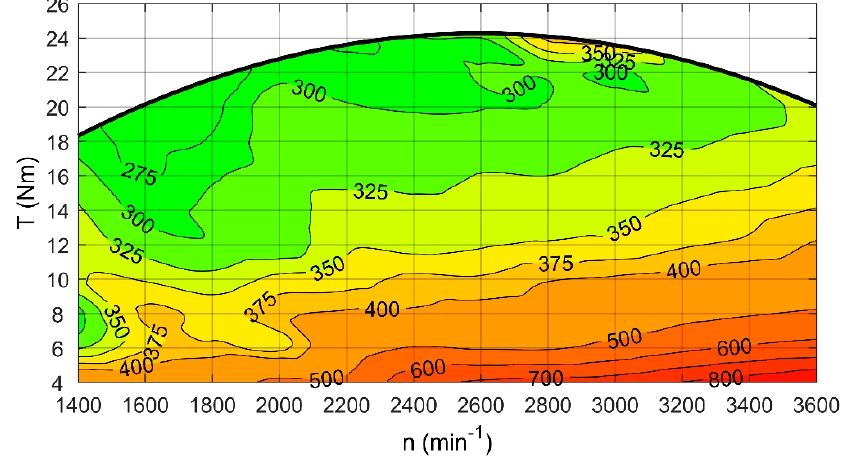
/ kWh) of the range extender supplied with Figure 7. BSFC (g/kWh) of the range extender supplied with gasoline. Figure 7. BSFC (g Figure 7. BSFC (g/kWh) of the range extender supplied with gasoline.